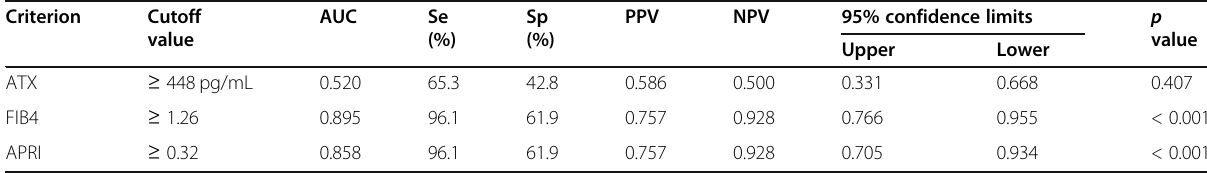
Table 4 The diagnostic performance for the detection of grade F3 – 4 fibrosis at baseline Criterion Cutoff